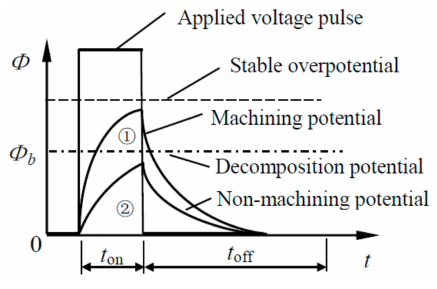
Figure 1. The double layer model.